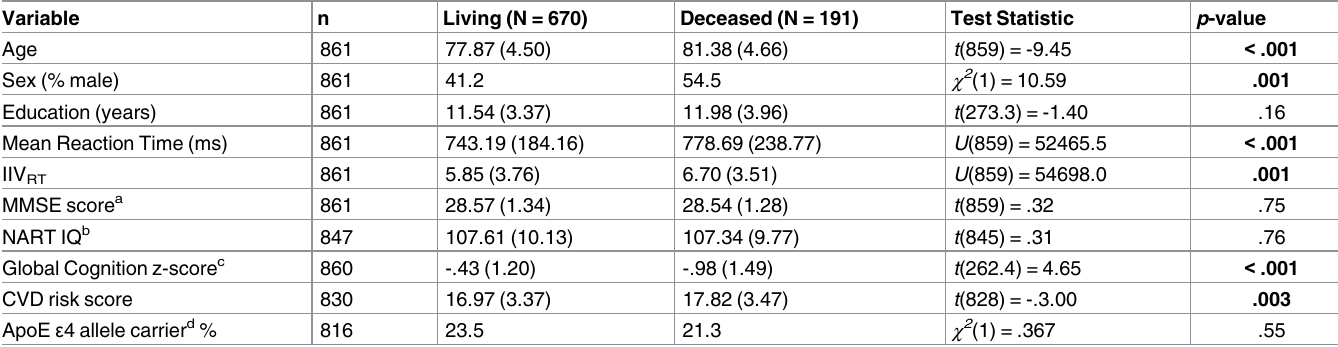
Table 1. Baseline characteristics based on vital status at 8